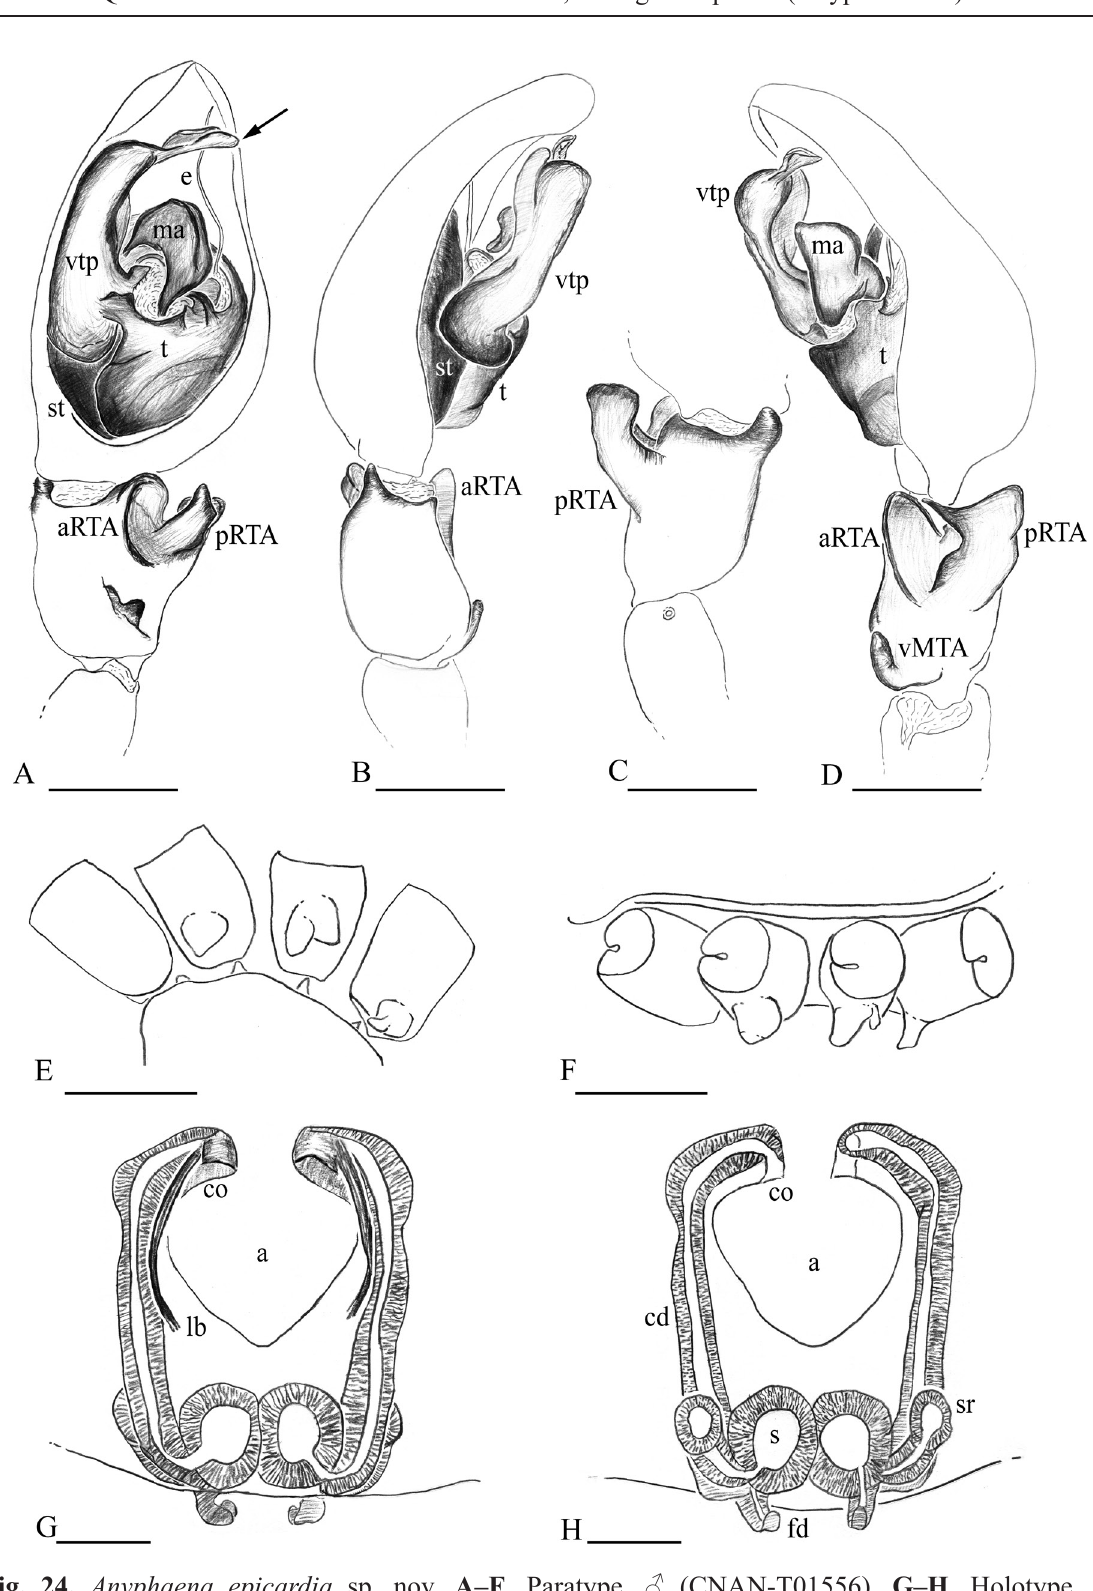
Fig. 24. Anyphaena epicardia sp. nov. A–F . Paratype, ♂ (CNAN-T01556). G–H . Holotype, ♀ (CNAN-T01557). A . Pedipalp, ventral view. B . Pedipalp, prolateral view. C . Pedipalp, dorsal view. D . Pedipalp, retrolateral view. E . Coxae, ventral view. F . Coxae, lateral view. G . Epigynum, ventral view. H . Epigynum, dorsal view. Scale bars: A–D, G–H = 0.2 mm; E–F = 1.0